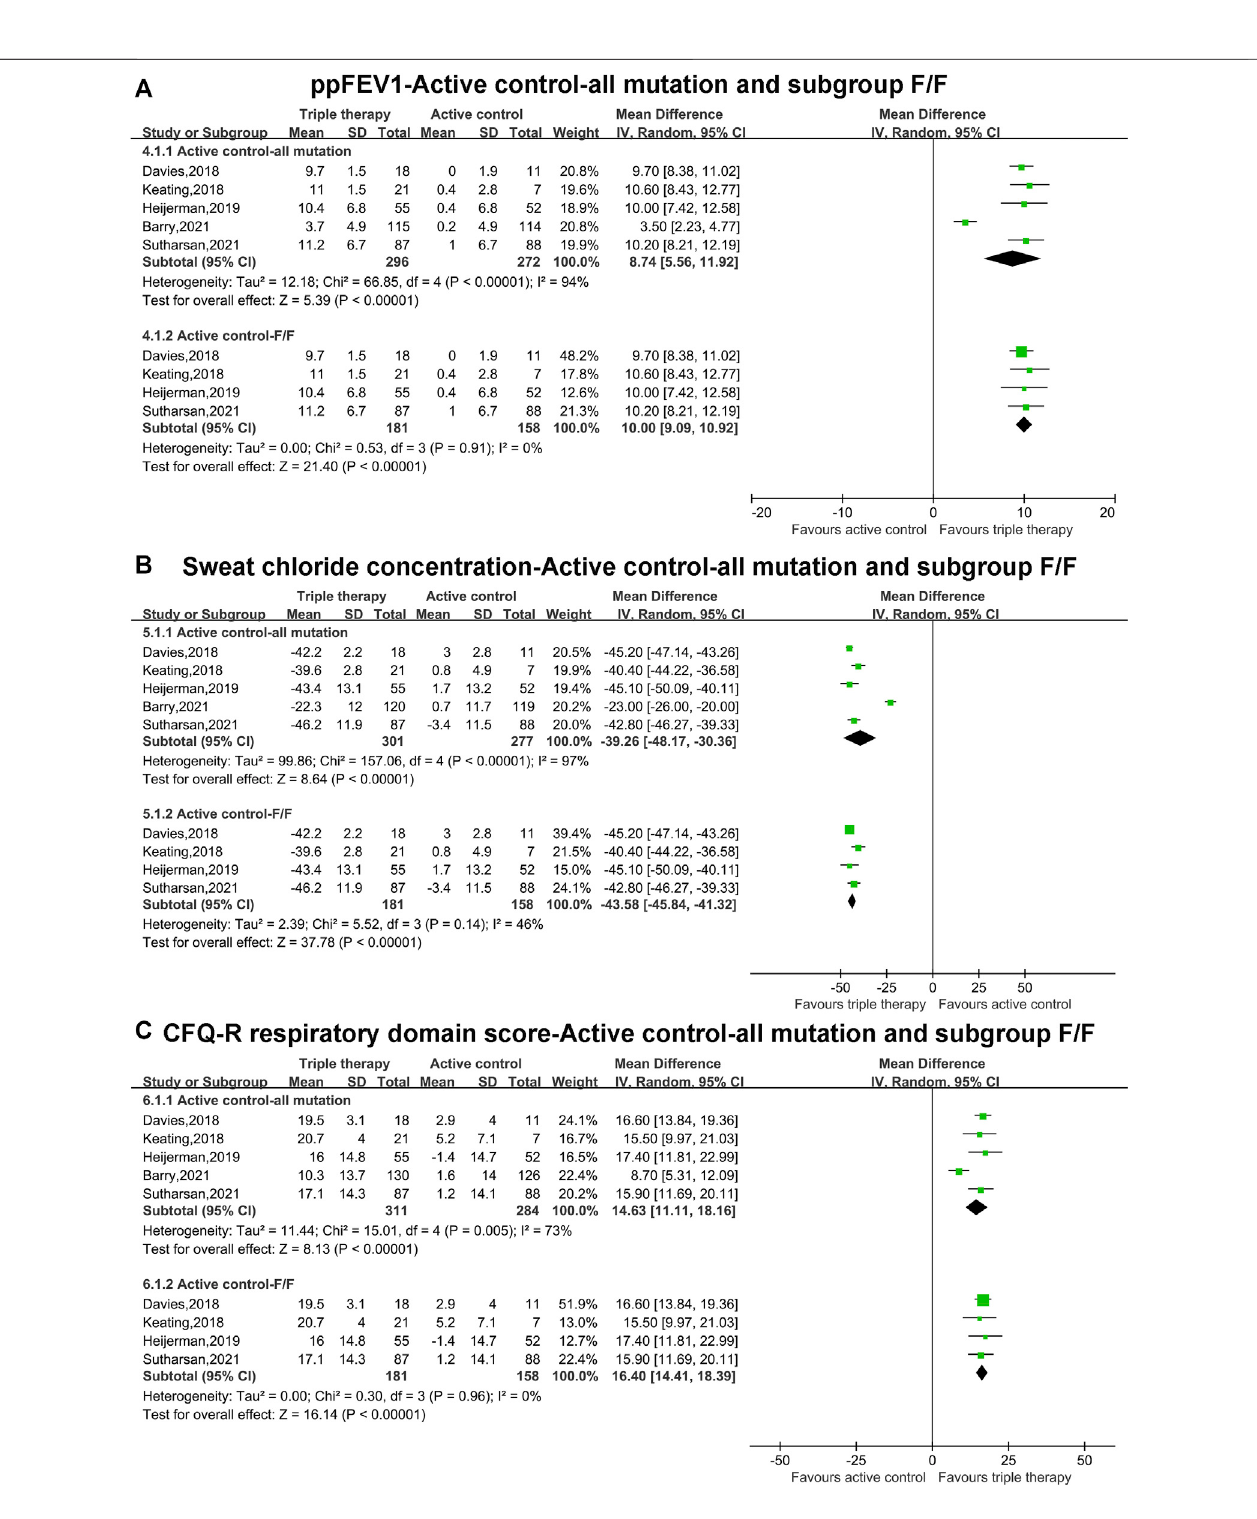
Frontiers in Pharmacology |